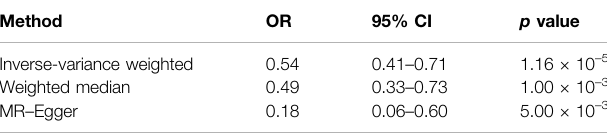
TABLE 2 | MR analysis results between educational attainment and